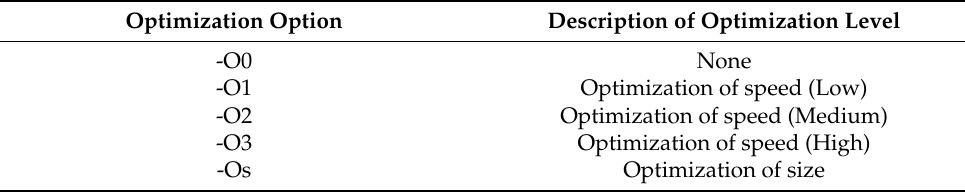
Table 3. Optimization level for each option.